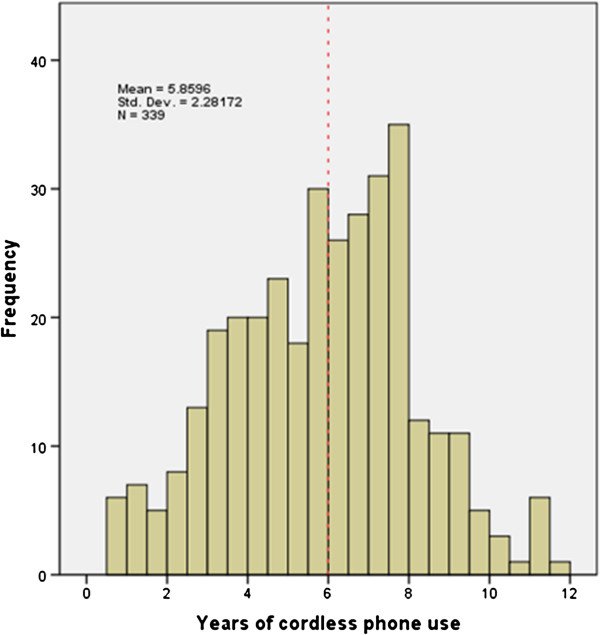
Short title: Years of cordless phone use at the time of the survey (mid 2009). Legend: The mean age participants reported starting cordless phone use was 6 ½ years. All bars to the right of the broken line indicate students who will have had ≥ 10 years’ use by mid-2013.